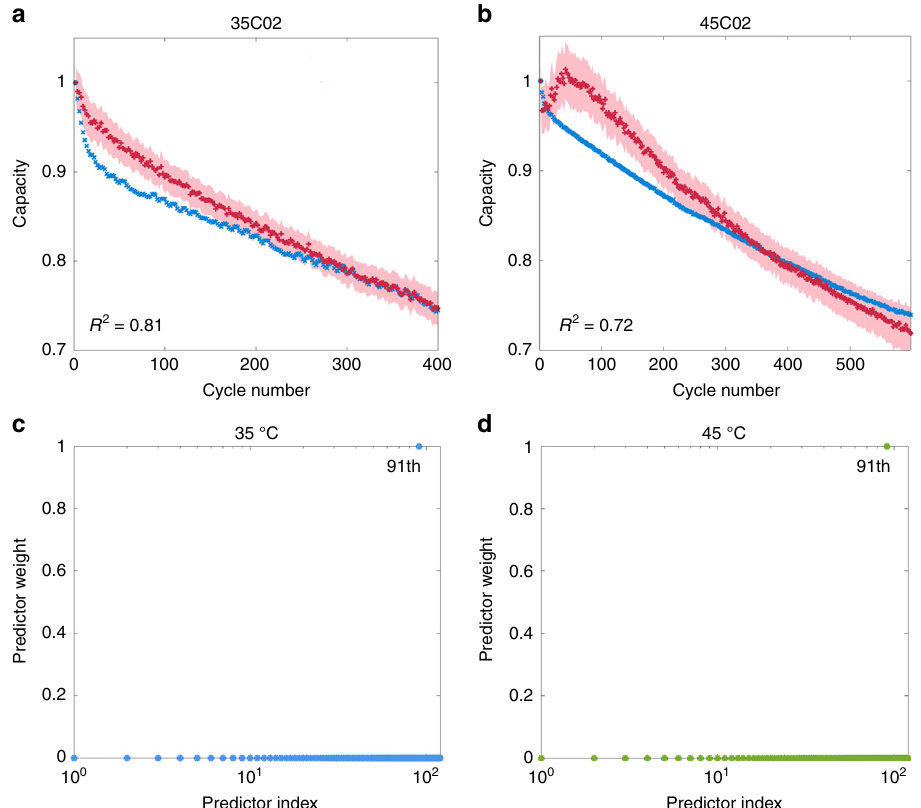
Fig. 3 Capacity estimation without de fi nite knowledge of the temperature. The curves show the estimated (red) and measured (blue) capacity for cell cycled at a 35 °C and b 45 °C; the cycling temperature is not an input to our model. The shaded area indicates ±1 standard deviation. Both EIS spectra are collected at the state V (15 min resting after fully charging). R 2 is shown on the left bottom in each panel. ARD shows that the EIS-capacity GPR models at 35 °C c and 45 °C d assign the largest weight to the 91st feature with the corresponding frequency of 17.80 Hz. The irrelevant features have weights close to